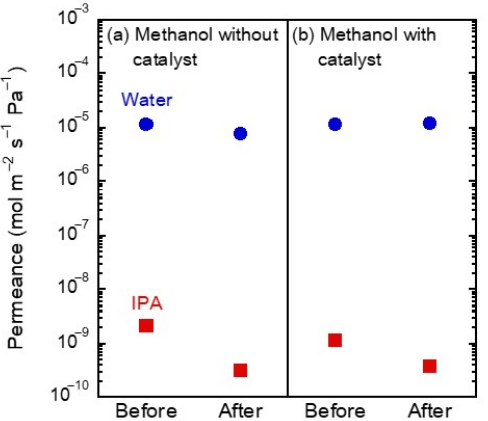
Figure 5. Water and 2-propanol permeances of the FAU-type zeolite membrane before and after methanol vapor exposure both ( a ) without catalyst and ( b ) with catalyst. Pervaporation performed with 10 wt% water/2-propanol at 348 K.